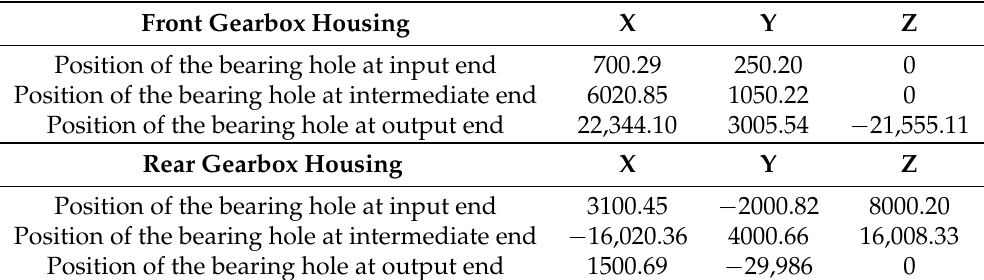
Table 4. Loads of each bearing hole in different directions under peak torque (unit: